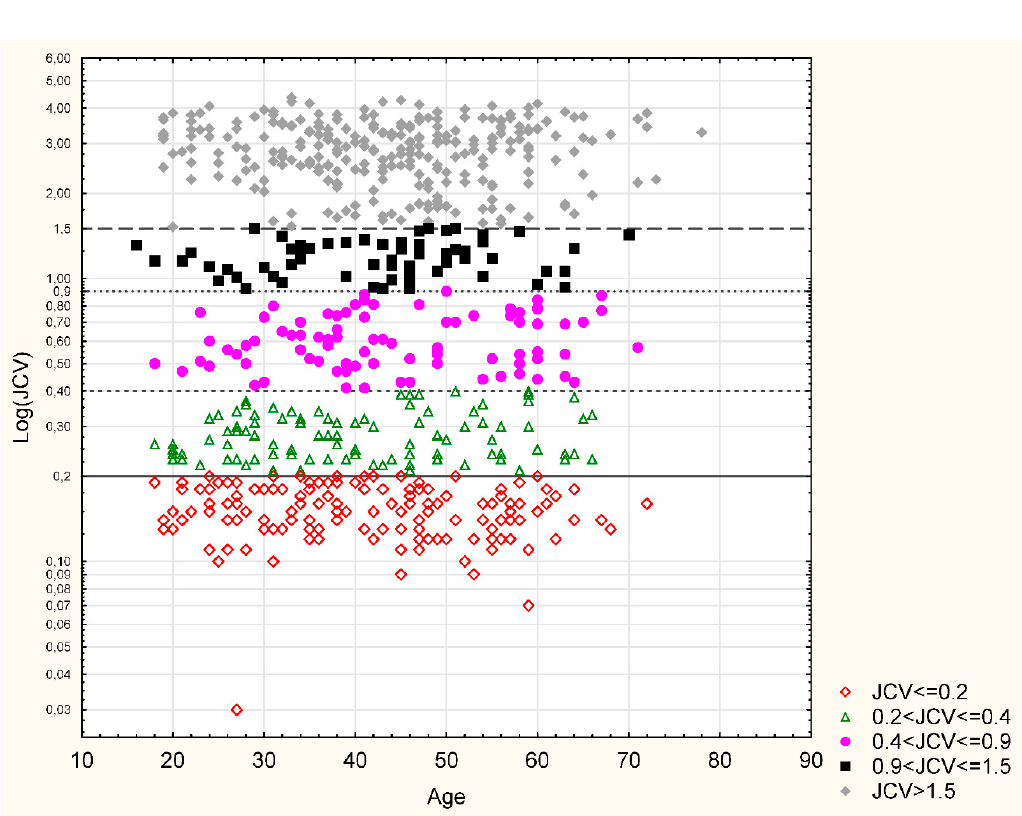
Figure 1. Anti-JCV antibody index (AI) categories and age.